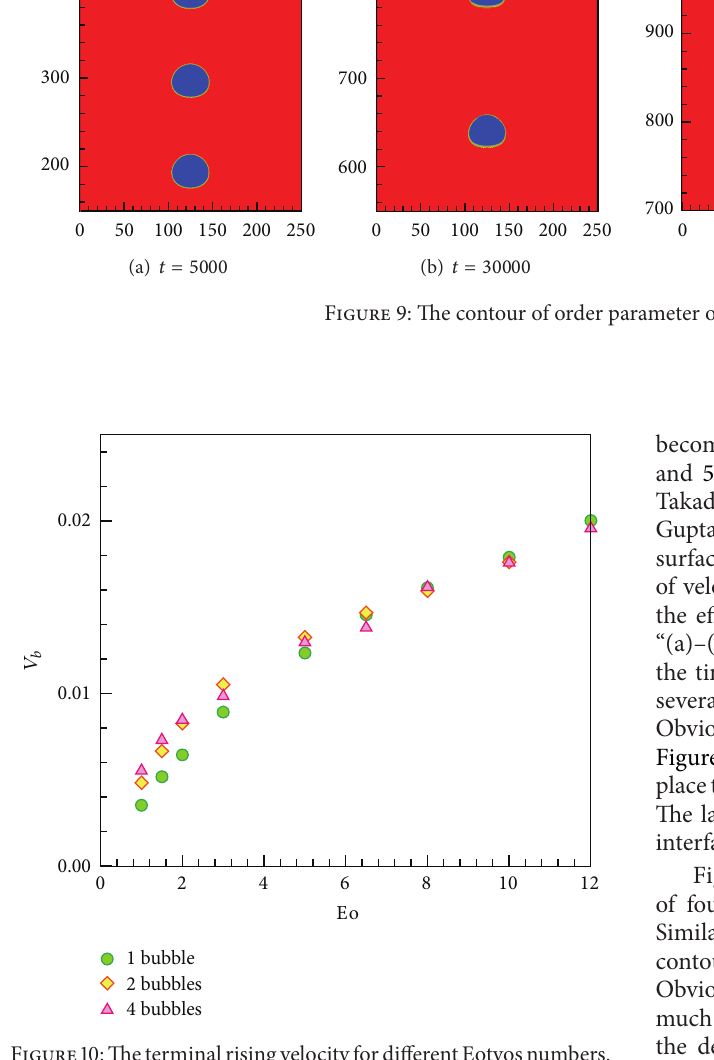
Figure10:TheterminalrisingvelocityfordifferentEotvosnumbers. The bubbles are placed in a vertical arrangement and the initial distance is 2.5 𝑅